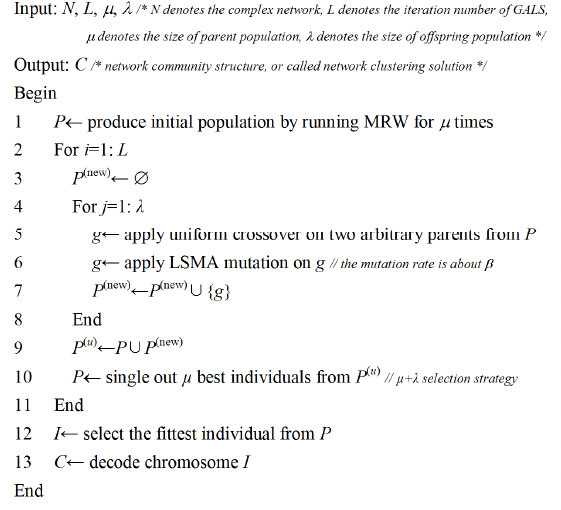
Fig. 4. LSMA algorithm.